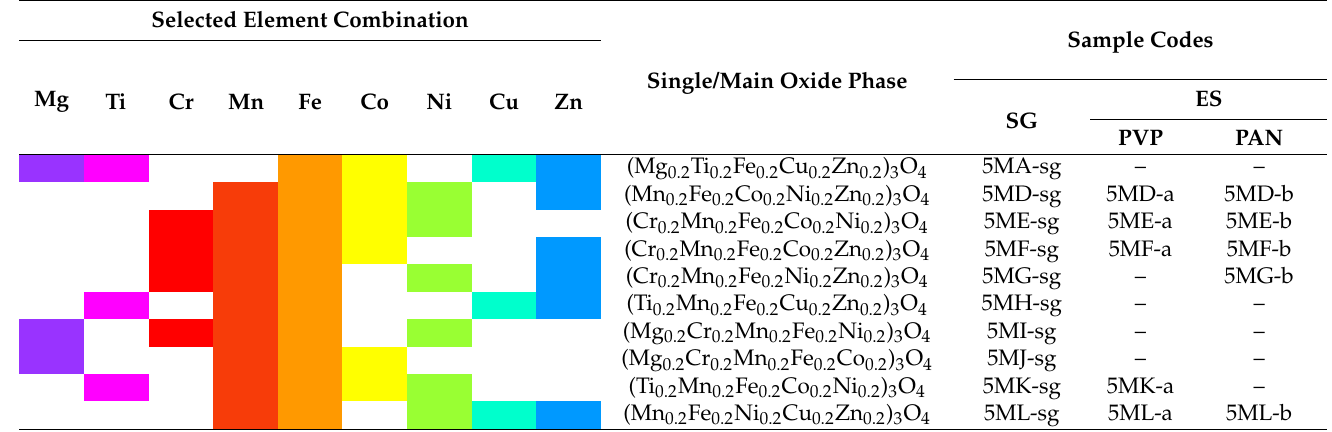
Table 1. Codes of samples prepared by sol-gel method (SG) method and electrospinning (ES) by using PVP or PAN as a